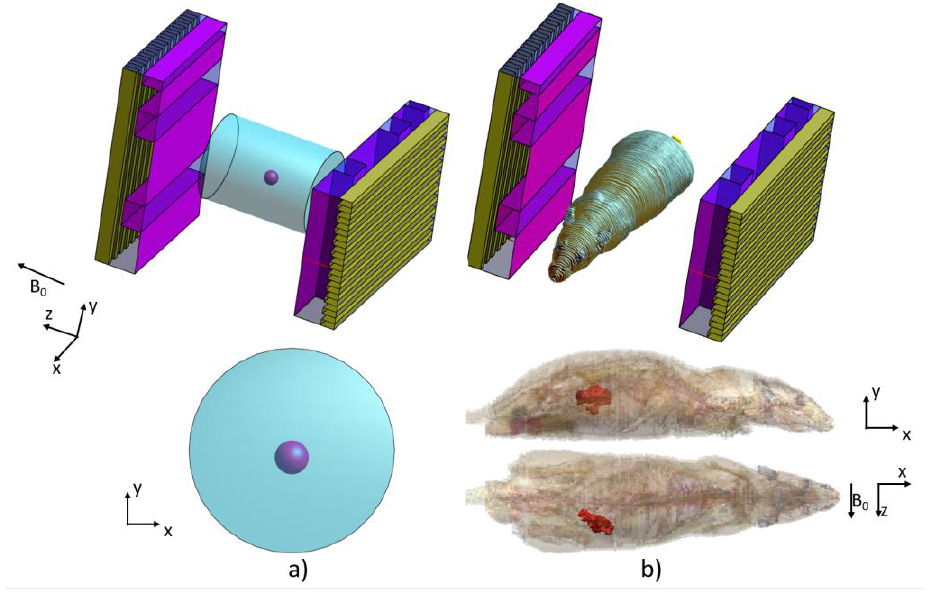
Figure 4. The arrangement of the double patch antenna ( a ) for a cylindrical phantom and ( b ) a rat model, showing the cancer-mimicking tissue.